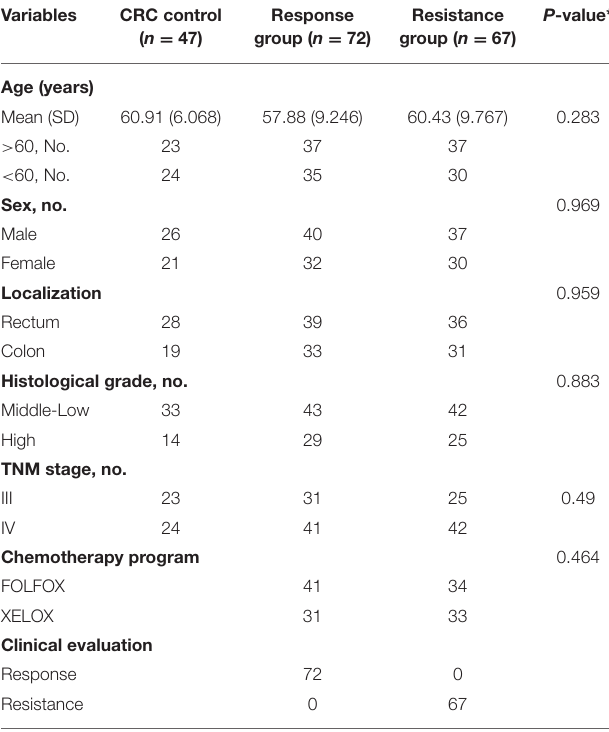
TABLE 1 | Clinical features of the patients in the validation